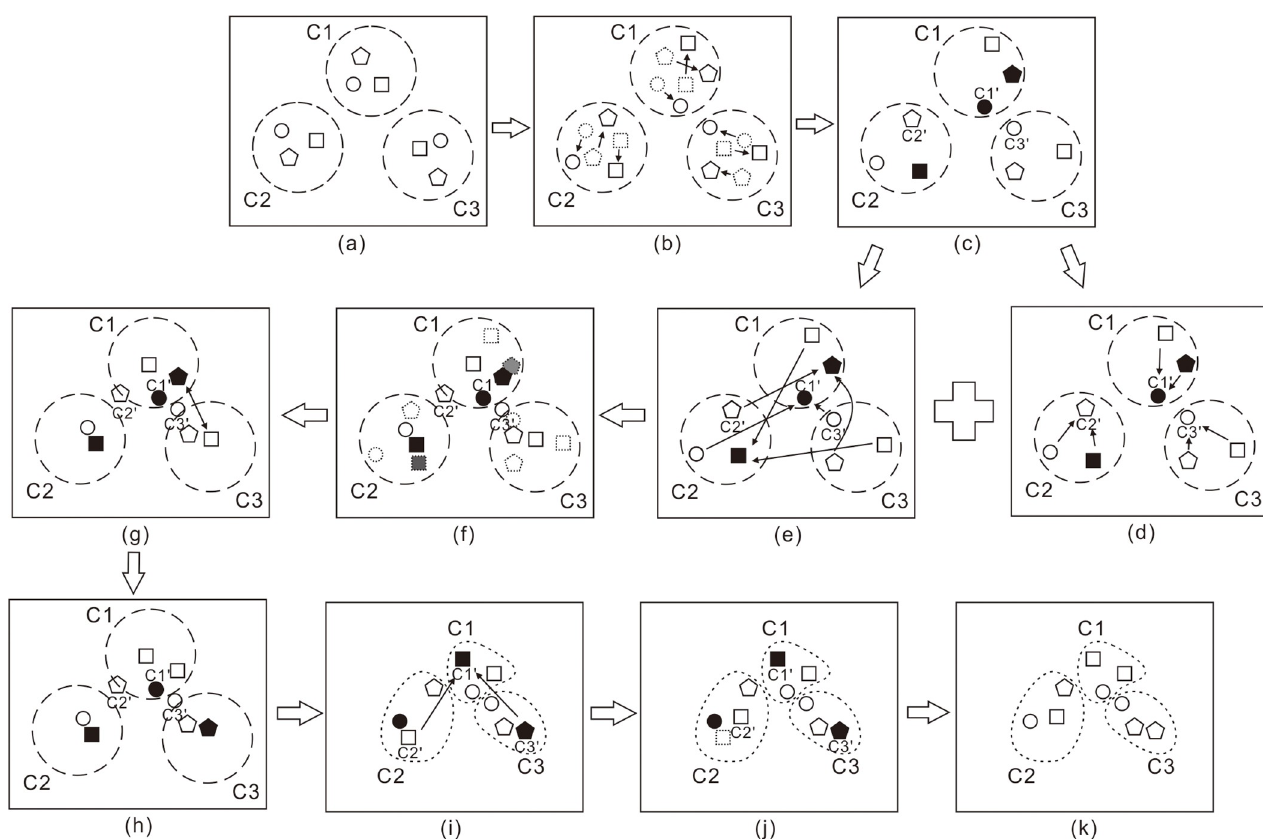
Fig 2. PO process. (A) Population initialization, different shapes refer to different parties. Quadrilaterals, pentagons, and circles represent political parties P 1 , P 2 , and P 3 , respectively. Dotted frames C1, C2, and C3 represent different constituencies. (B) Members of various political parties conduct canvassing activities within their respective constituency. (C) Party leaders (solid) and constituency winners C1’, C2’, and C3’ are determined. (D) Update the positions of party members according to the constituency winners. (E) Update the positions of party members according to the party leaders. (F) The resultant positions are synthesized according to the position of the constituency winners and the party leaders. (G)(H) party switch, p 3 constituency C1. (I) election phrase and reassign party leaders and constituency winners. (J) parliamentary affairs: each parliamentarian is updated if its fitness is improved after being attracted by a random parliamentarian. (K) final positions after one iteration.